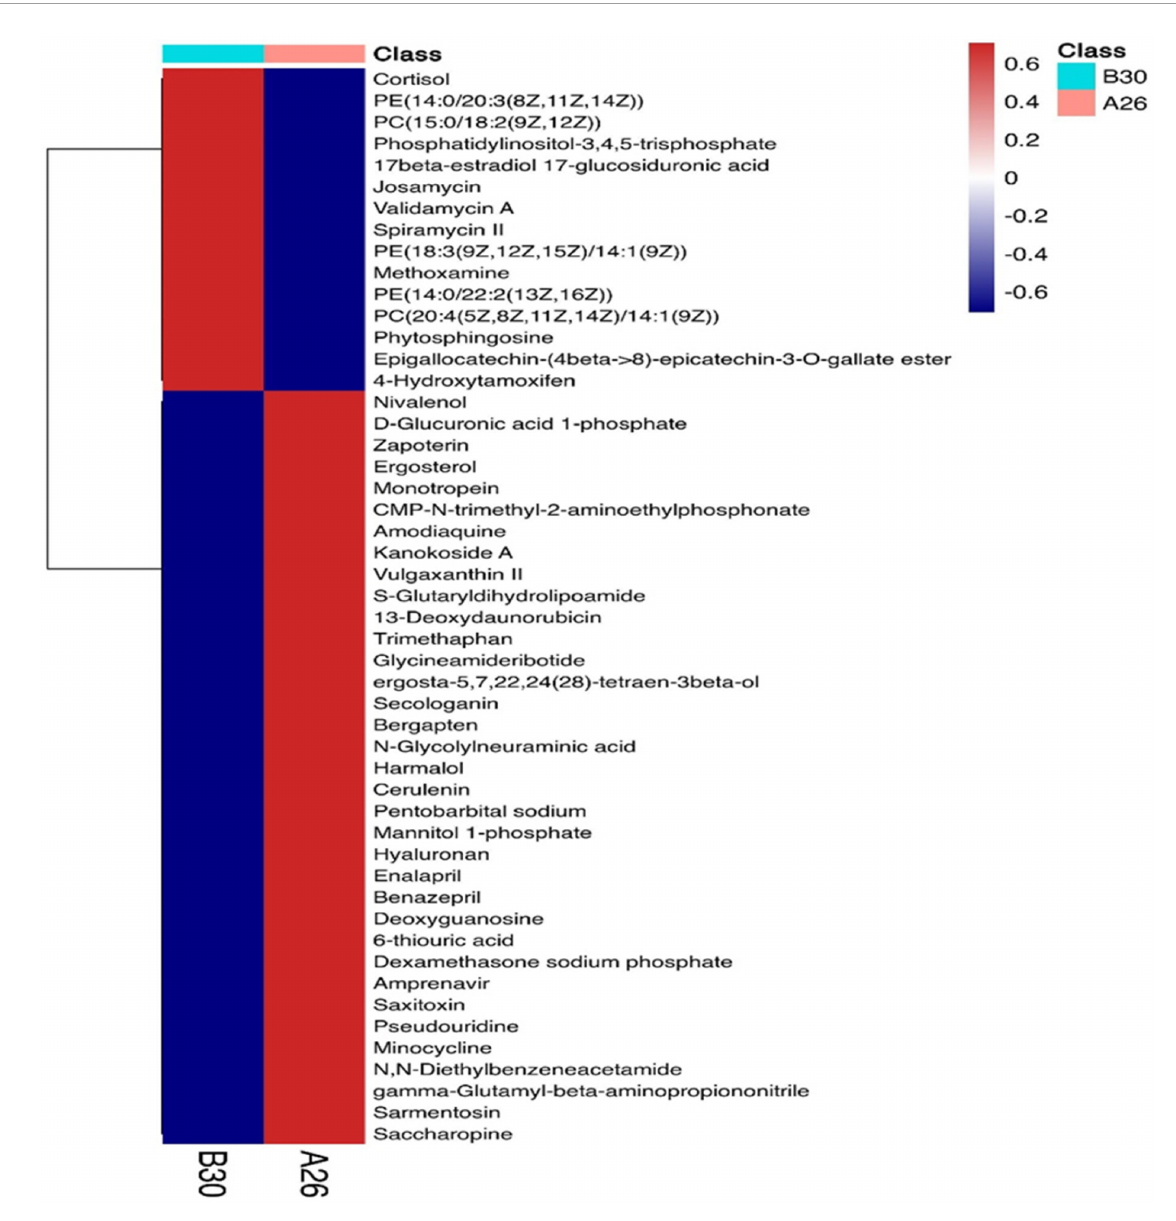
FIGURE5 Heatmap cluster of top 50 differential antifungal